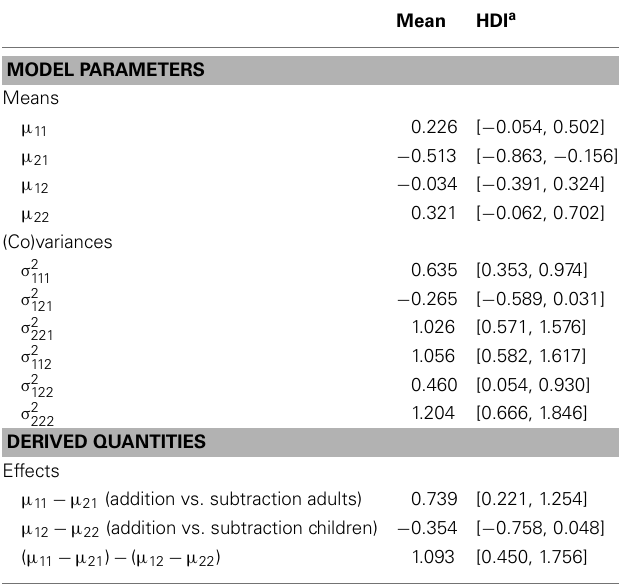
Table 2 | Marginal posterior densities from the Bayesian